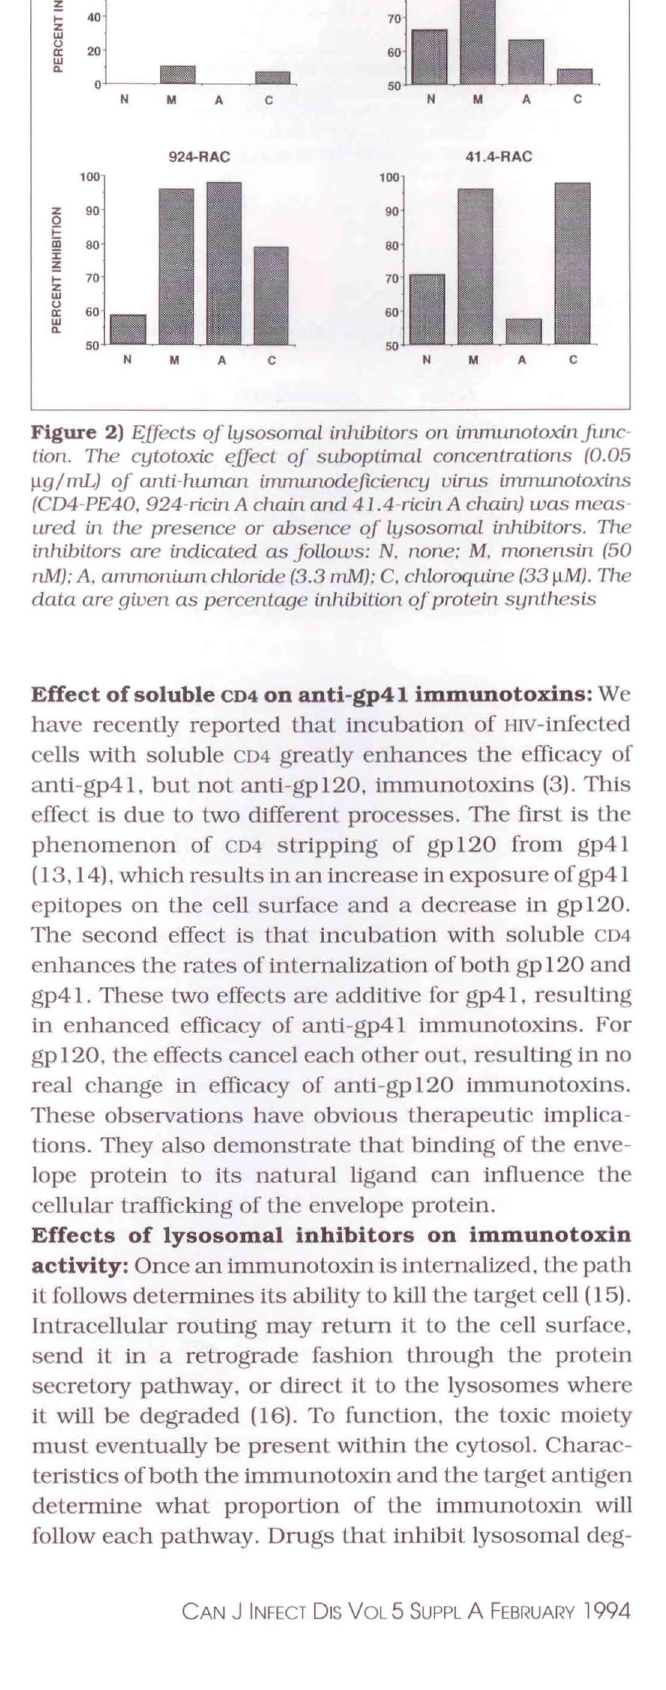
Figure 1) Western blot of immunotoxin resistant variant cells: cell lysates were run on SDS-PAGE, blotted onto nitrocellulose and detected with anti-gpl 60 antibodies. H9 cells were unin f ected, H9/NLA-3 were the parental cells of the variants. and G4